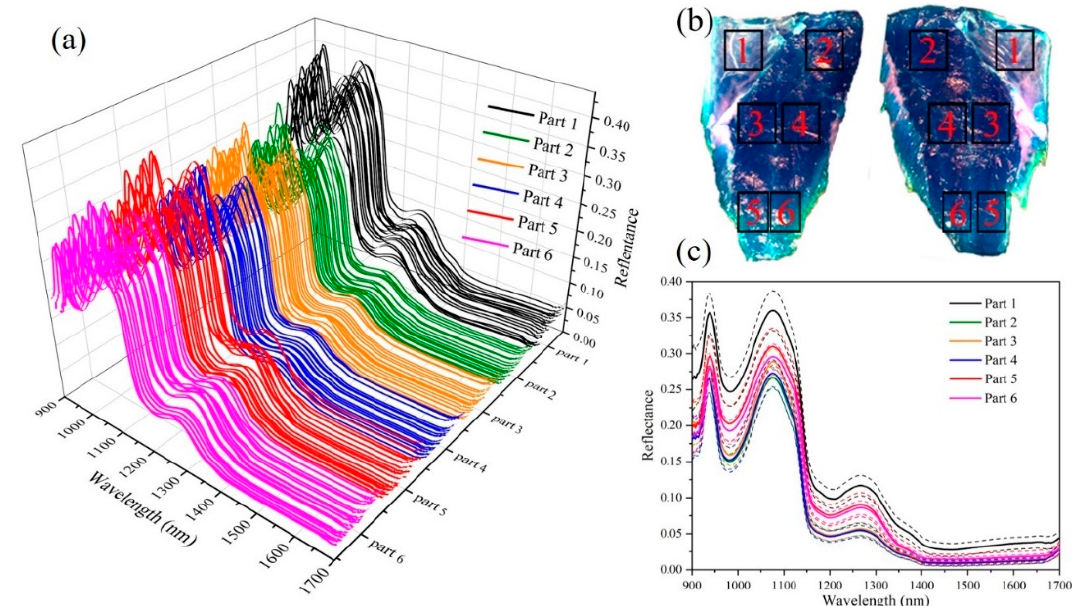
Figure 2. Hyperspectral data of different parts of 22 fresh fish: ( a ) Raw spectra of 6 parts of 22 fresh fish; ( b ) 6 parts of fish sample; ( c ) mean and standard deviation spectra of 6 parts.